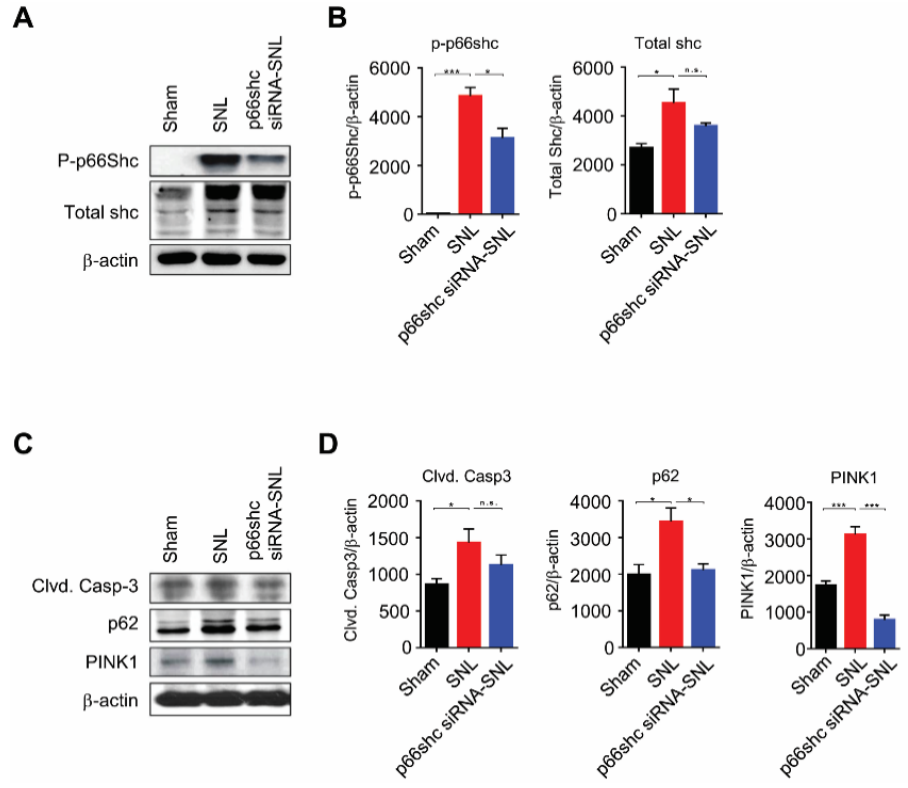
Figure 3. p66shc siRNA-PLGA NPs reduced the protein levels of cleaved caspase-3, p62, and PINK1 in the ipsilateral spinal cord at 7 days after SNL. ( A , B ) phosphorylation of p66shc was decreased after treatment with p66shc siRNA-PLGA NPs; ( C , D ) SNL-induced increases in cleaved caspase-3, p62, and PINK1 protein levels were significantly attenuated in the p66shc siRNA-SNL group. β -actin was used as a loading control. Data are expressed as means ± SEM (unpaired Student’s t -test, *** p < 0.001, ** p < 0.01, * p < 0.05 vs. sham or SNL group).